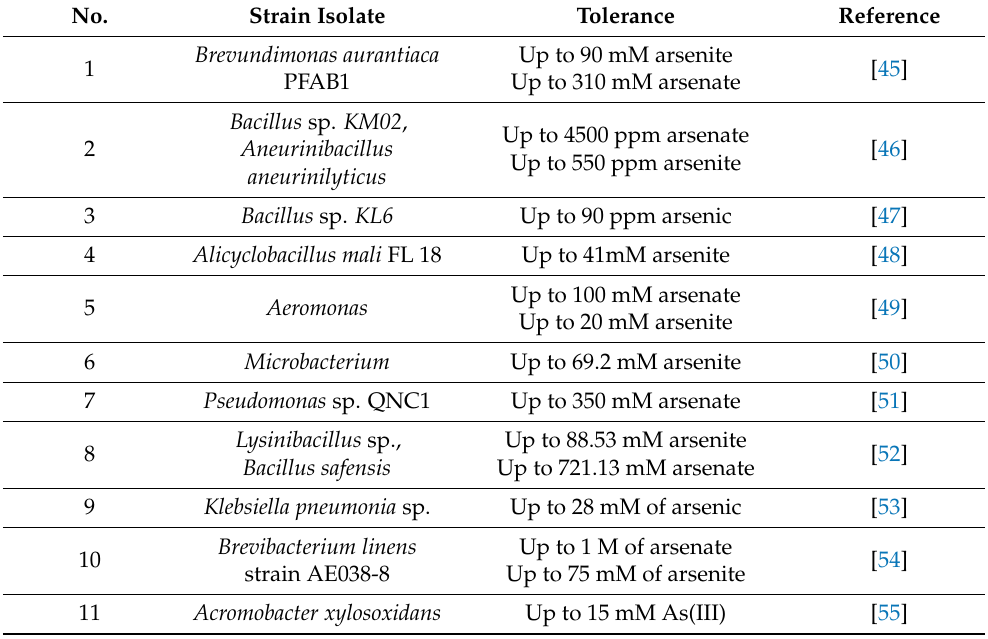
Table 1. Arsenic-tolerant microbial